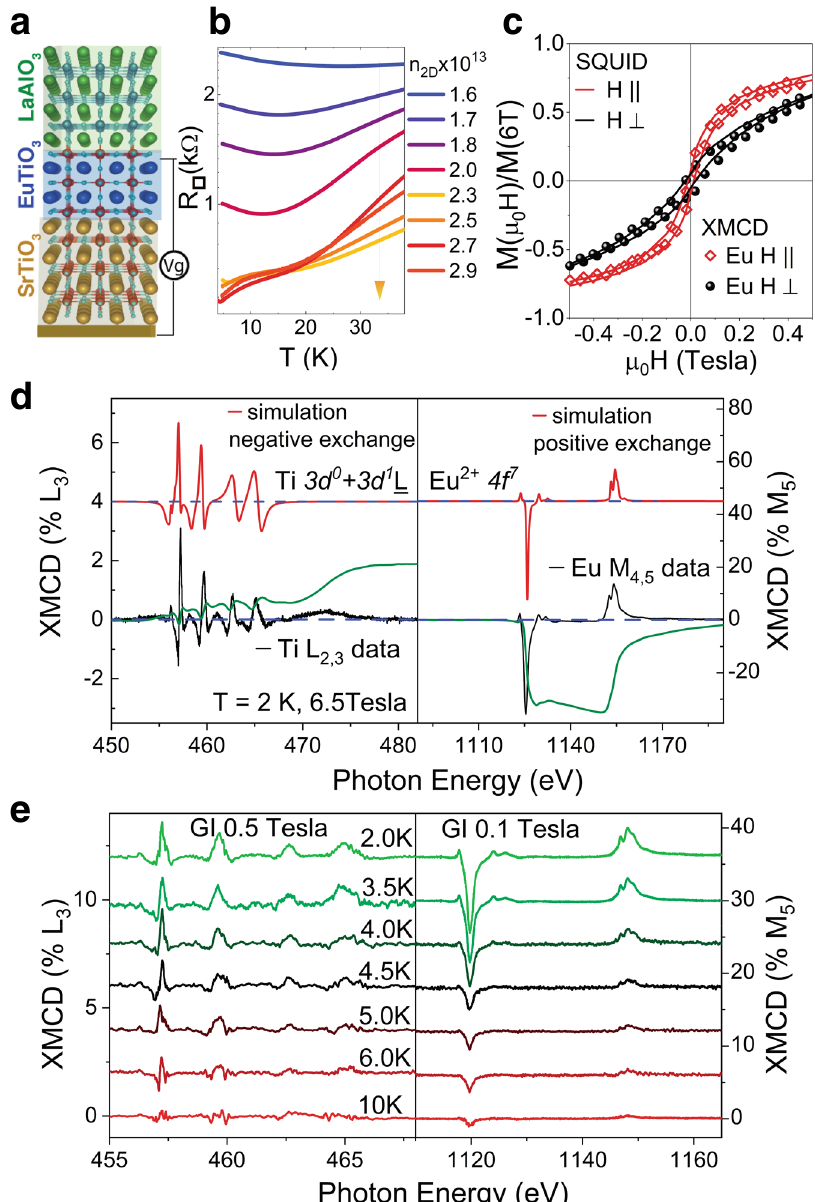
Fig. 1 Transport and magnetic properties of LAO/ETO/STO heterostructures. a Sketch of the LAO/ETO/STO heterostructure. In this work, the carrier concentration was tuned using electric fi eld effect in back-gate con fi guration, as sketched in the fi gure. b Sheet resistance vs. temperature as a function of the gate voltage V g . The arrow indicates increasing values of V g from − 30 to 30 V and 2D carrier density. c Eu- XMCD (scatter data) and SQUID magnetization (continuous lines) as function of the magnetic fi eld parallel (red) and perpendicular (black) to the interface. The data are normalized to the saturation value. The Eu-XMCD in parallel direction is obtained by combing data acquired in grazing (60 degrees from the surface normal) and normal incidence conditions. d XMCD data at the Ti-L (left) and Eu-M (right) edges at 6.5 Tesla and 2 K. Red-lines are atomic multiplet simulations, green lines are integrals of the XMCD spectra (see main text). e Temperature dependence of the Ti-L 2,3 (0.5 Tesla) and Eu-M 4,5 (0.1 Tesla) edges XMCD spectra in grazing incidence conditions. Data are vertically shifted for